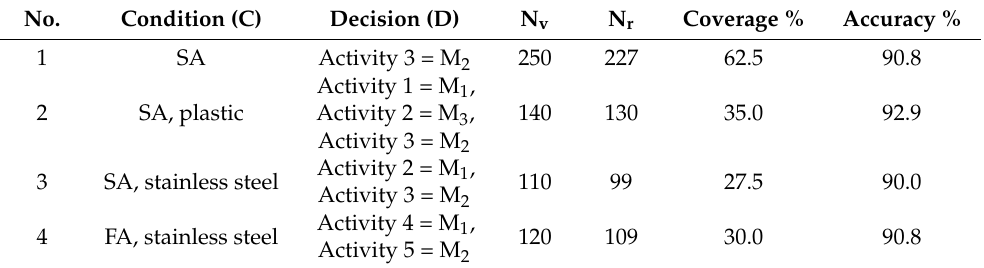
Table 17. Prediction results of significant rules of maintenance activities with